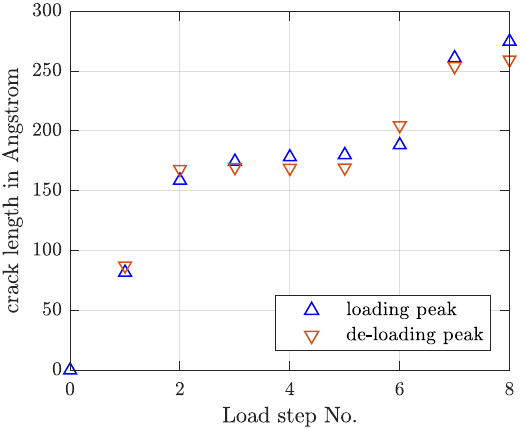
Figure 9. Single under-load event.